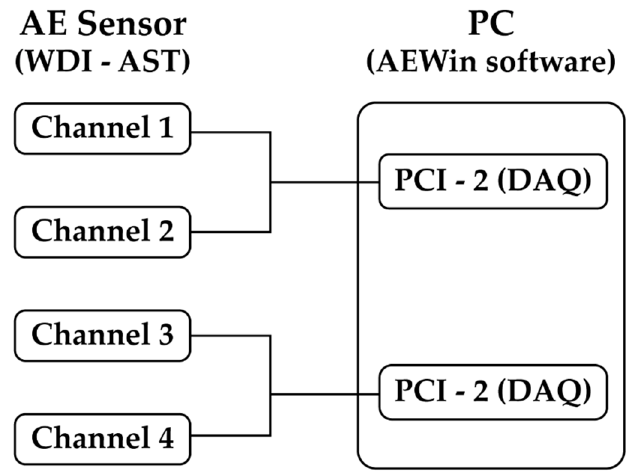
Figure 4. Setup of data acquisition devices and channels.